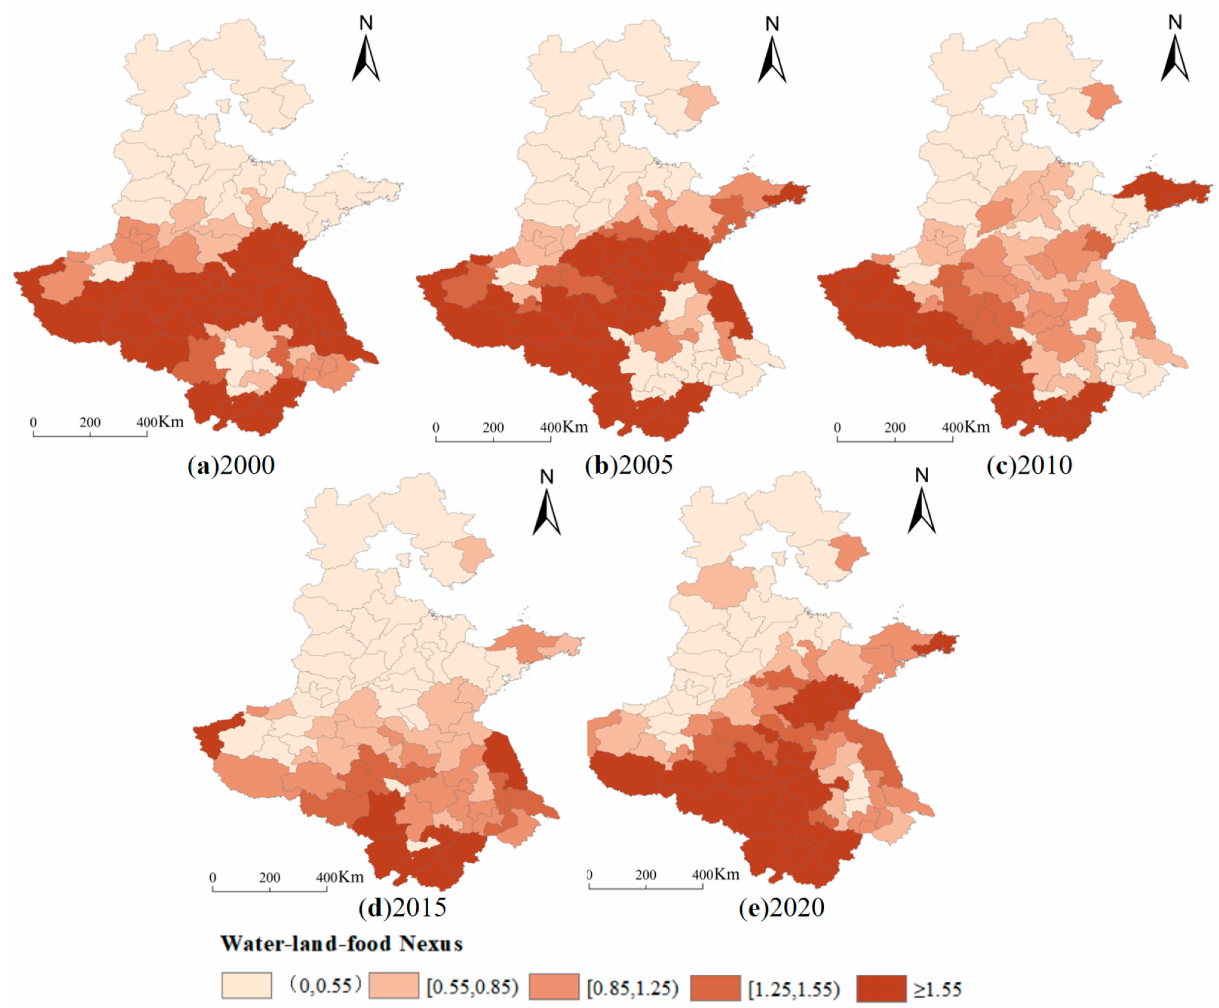
Figure 7. Spatial and temporal variation of the water–land–food nexus. ( a ) 2000 ( b ) 2005 ( c ) 2010 ( d ) 2015 ( e )